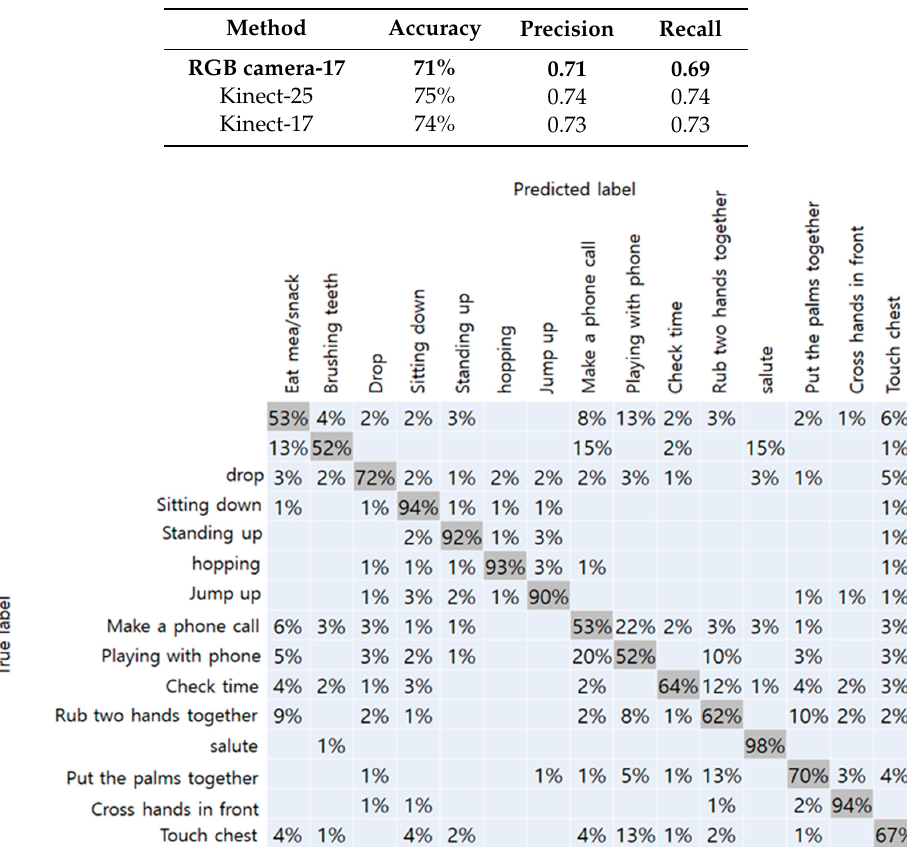
Table 1. Accuracy by camera and number of joints.